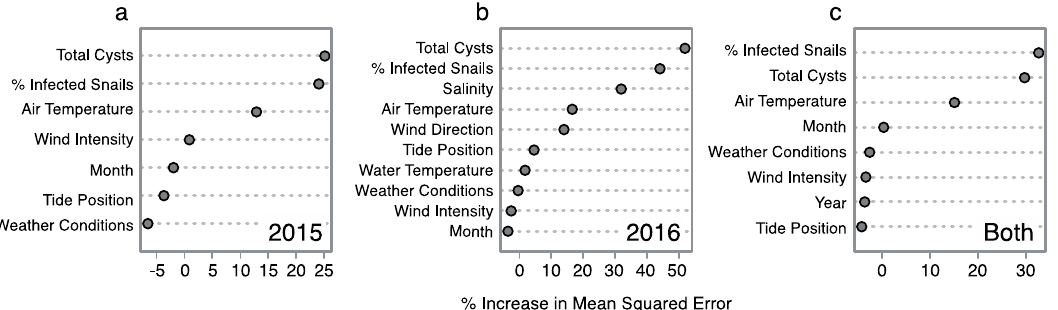
Figure 3. Variable importance plots for predictor variables from random forest (RF) classifications used for predicting terrapin visual counts in ( a ) 2015, ( b ) 2016, and ( c ) both 2015 and 2016 combined. The mean decrease in accuracy from the permuted out-of-bag (OOB) observations compared to the original values is reported as percent increase in mean squared error. Higher values of percent increase in mean squared error indicate variables that are more important to the classification.